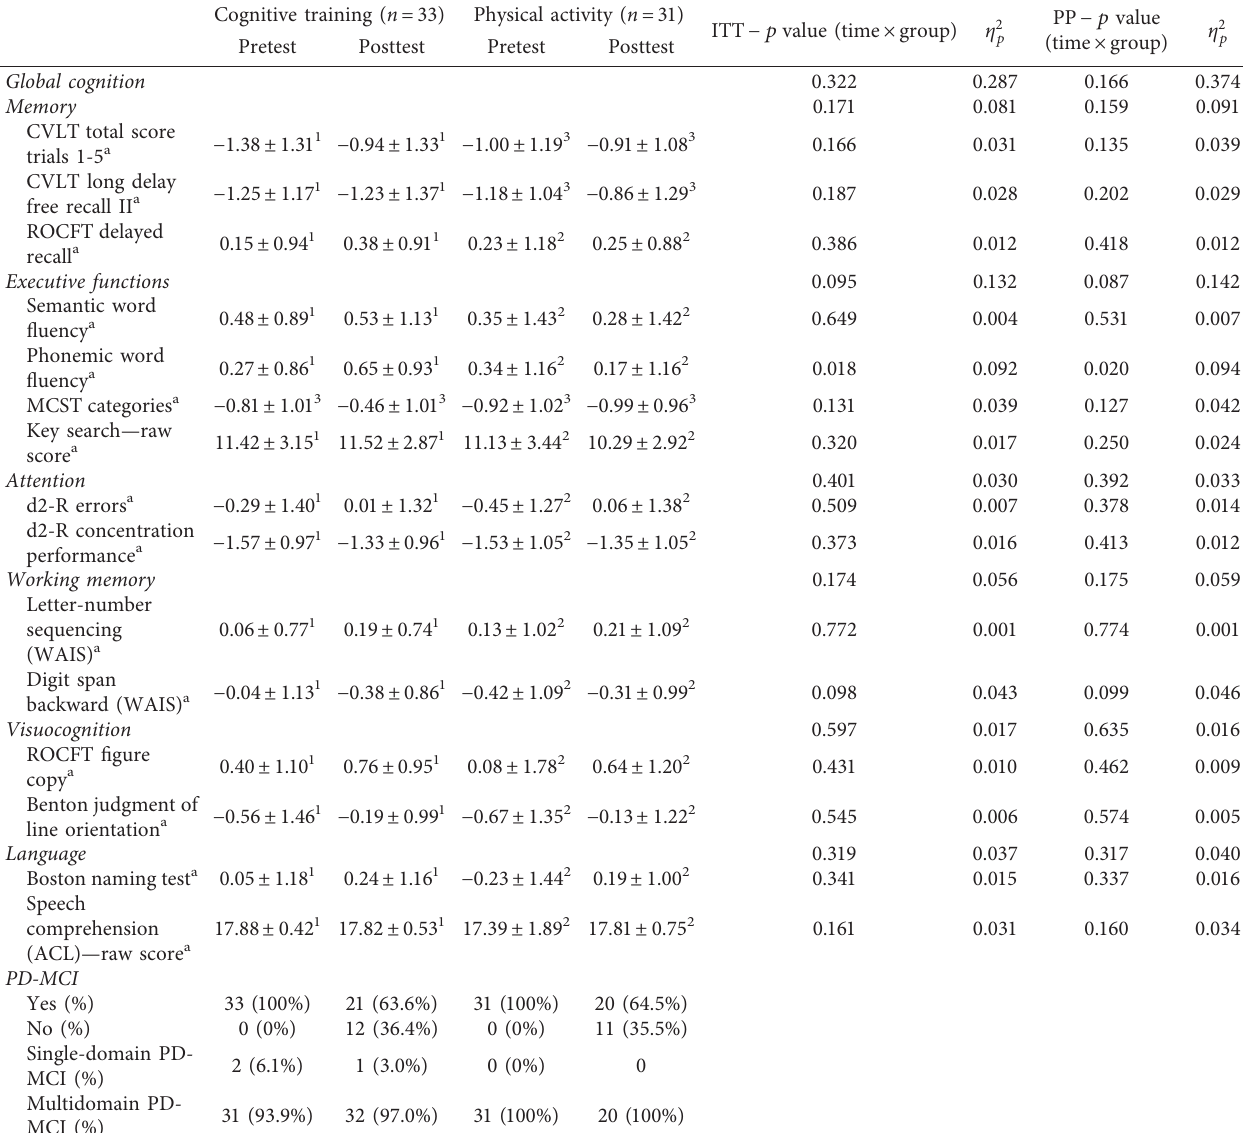
Table 1: Training effects for cognitive outcomes for both groups at the pre- and